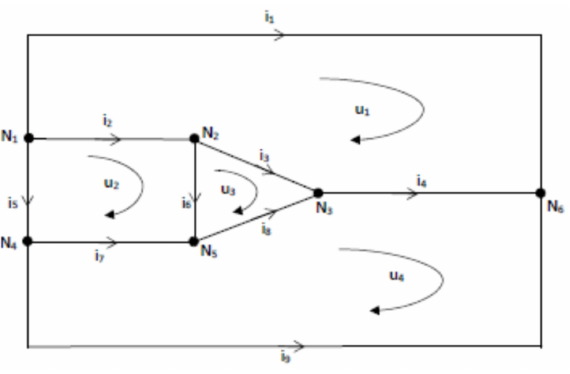
Figure 3. An electrical